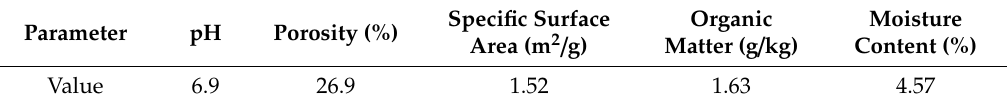
Table 2. Soil sample properties and characteristics.